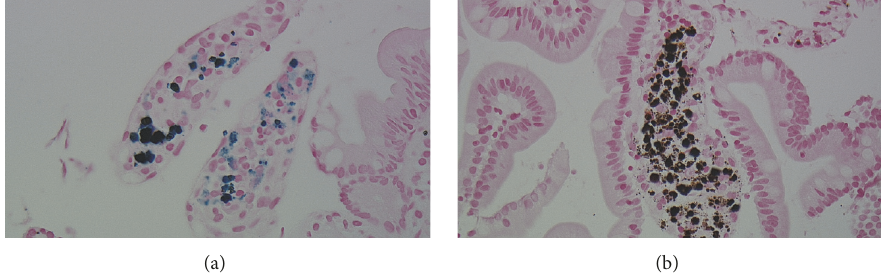
Figure 3: Panel of two images; Prussian blue stain ( × 600) with blue pigment deposition confirming the presence of iron within histiocytes (a). And Fontana Masson stain ( × 600) of the small intestine with brown-black pigment deposition consistent with melanin or melanin-like substance deposition in the macrophages